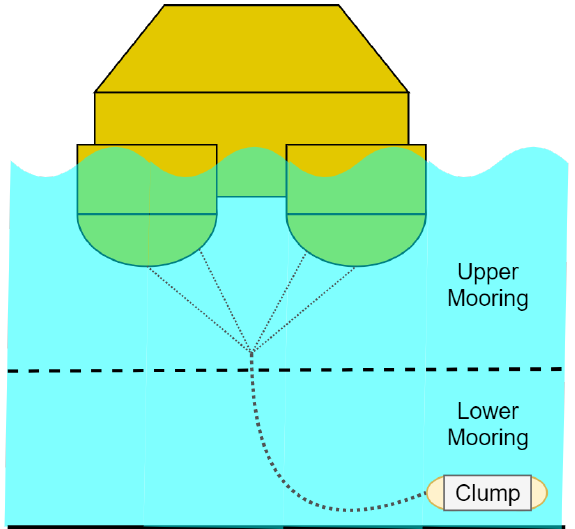
Figure 2. Mooring system scheme of the lidar buoy prototype used in the IJmuiden